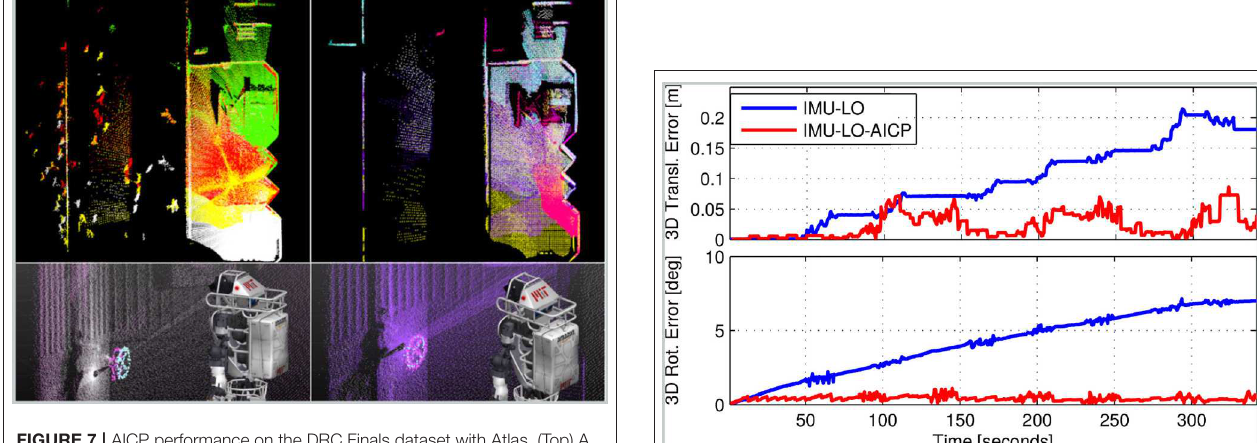
FIGURE 7 | AICP performance on the DRC Finals dataset with Atlas. (Top) A top view of the alignment of 206 point clouds during the run—left: raw clouds with people, right: filtered clouds. Bottom left: state estimation without applying correction, valve perceived in different locations by successive clouds. Bottom right: with successful localization, consistent estimate of the